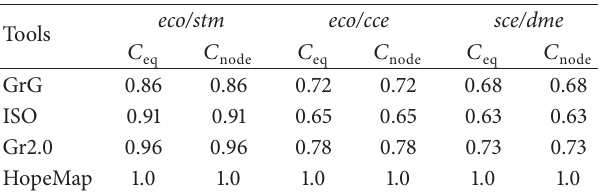
Table 5: Specificity comparison in terms of KO groups for different alignment tools.